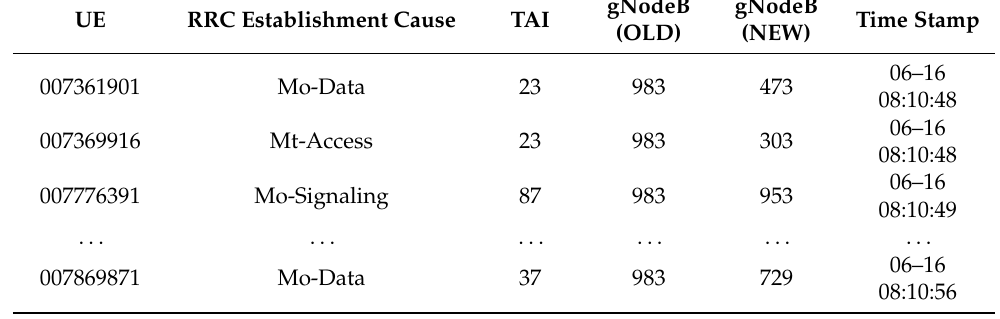
Table 6. Example of UE movement data. Mo-data: mobile originating-data, mt-access: mobile terminating-access, and mo-signaling: mobile originating-signaling.